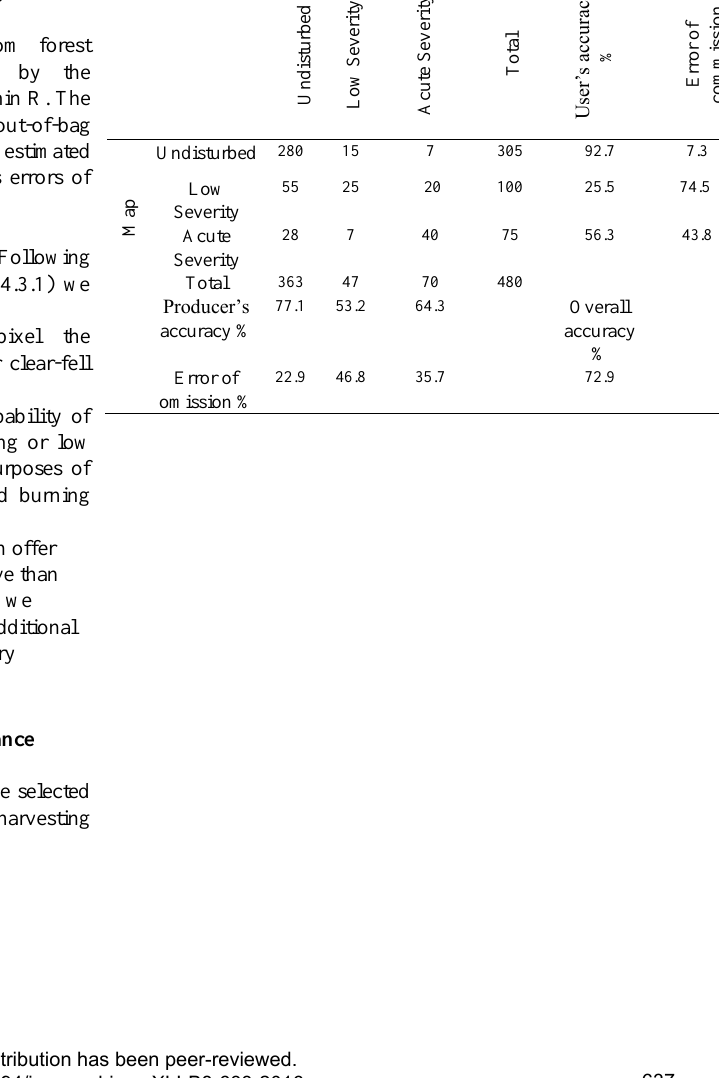
Figure 3: Example of pixel trajectories with related Landsat imagery for (A) no disturbance (B) acute high severity (clearfell) (C) low severity (planned burning)